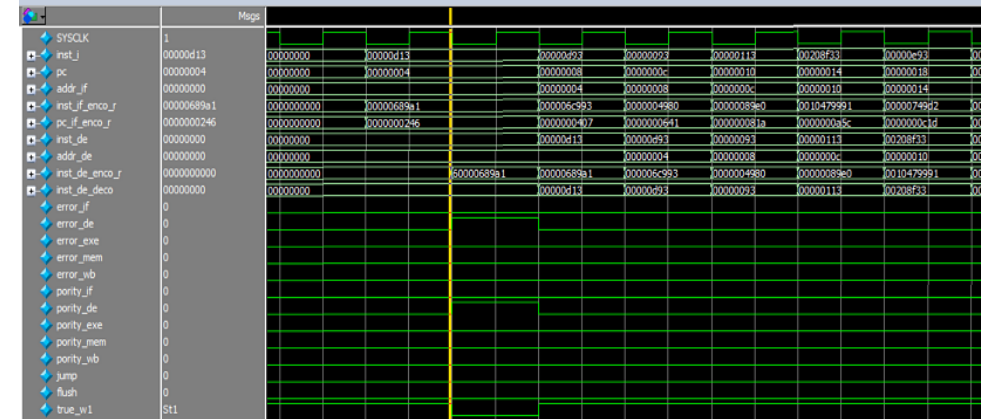
Figure 25. Decoding-stage error rollback strategy. Code 1. rv32ui-p-add partial assembly code example-1.